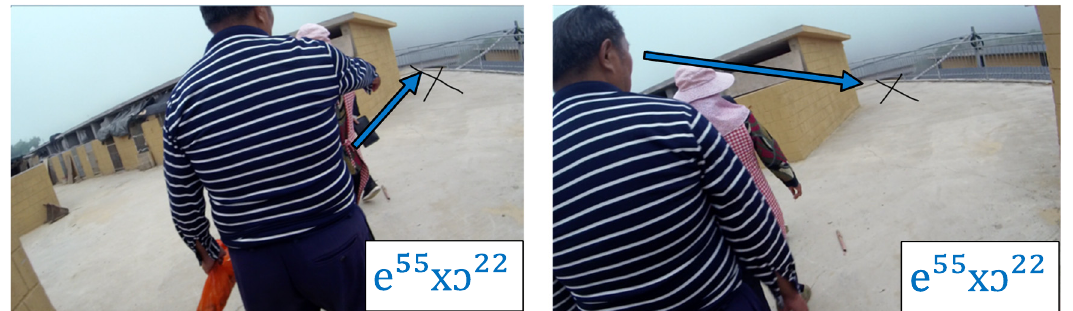
Figure 10: BTL uses speaker deictics while pointing towards the right - hand path.